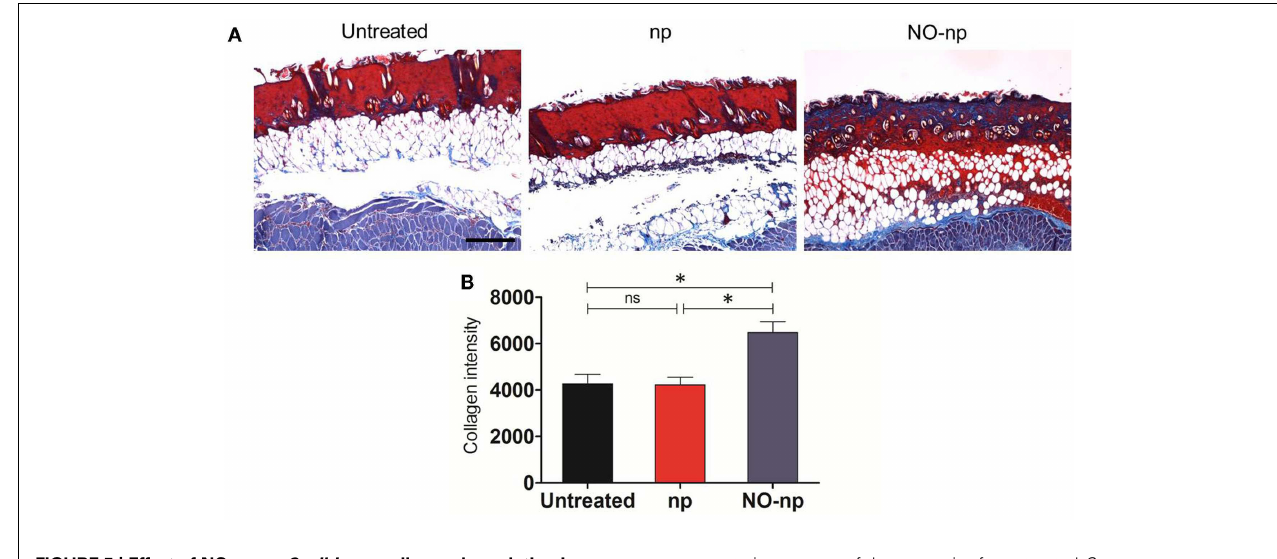
FIGURE 5 | Effect of NO-np on C. albicans collagen degradation in burn injuries. (A) Histological analysis of Balb/c mice untreated C. albicans -infected, np-treated C. albicans -infected, and C. albicans -infected treated with NO-np, day 7. Mice were infected with 10 7 fungal cells.The blue stain indicates collagen. Scale bar: 20 µ m. (B) Quantitative measurement of collagen intensity in 20